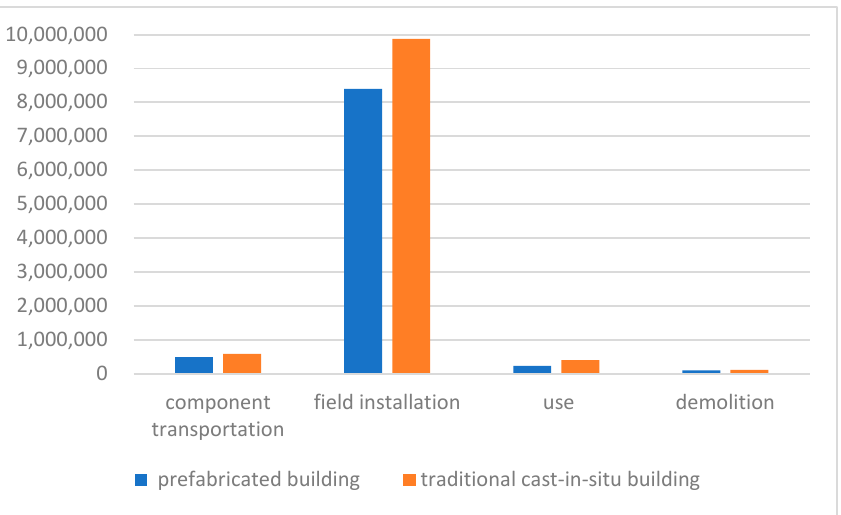
Figure 5. Carbon emissions of each stage in prefabricated buildings and traditional cast-in-situ